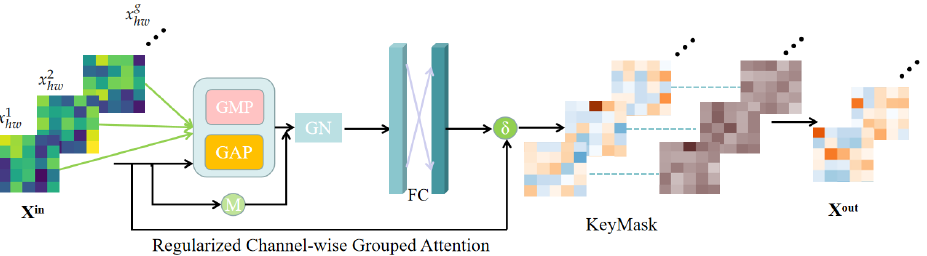
Figure 2. Illustration of the proposed Local Focus Scheme. The Local Focus Scheme consists of two key parts: the regularized channel-wise grouped attention and